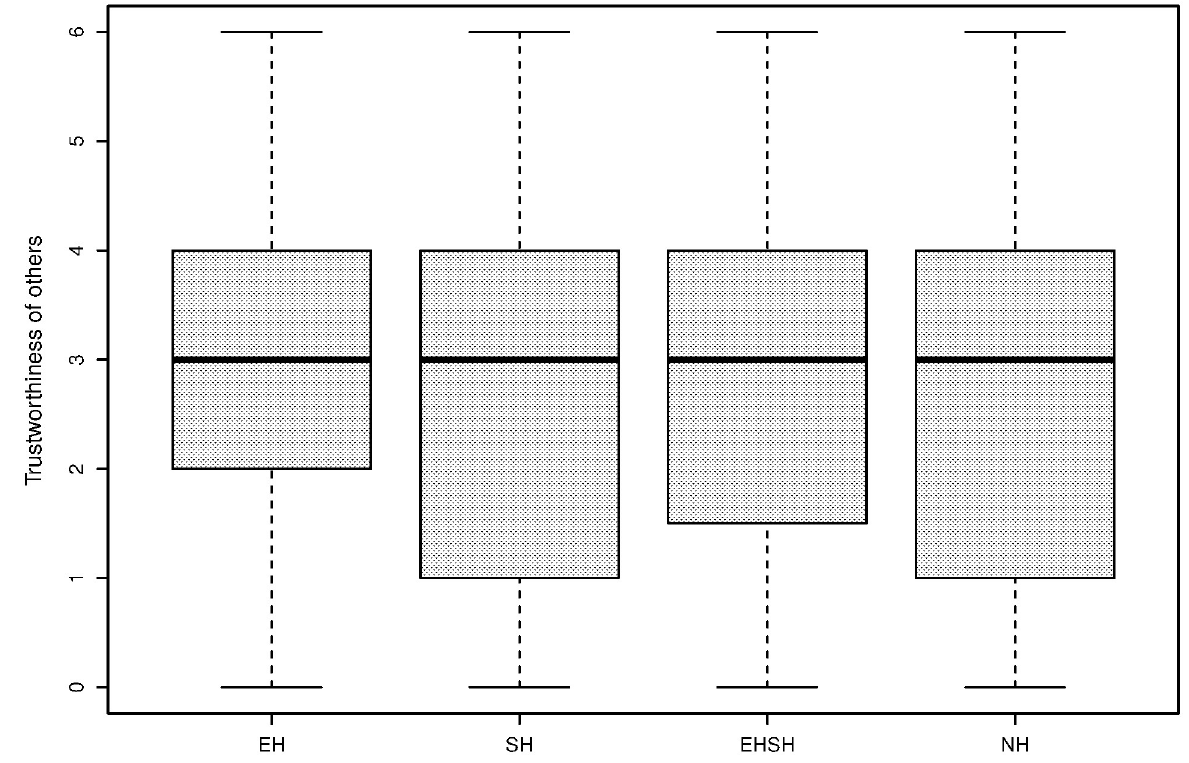
Fig 11. Subjective trustworthiness other players by